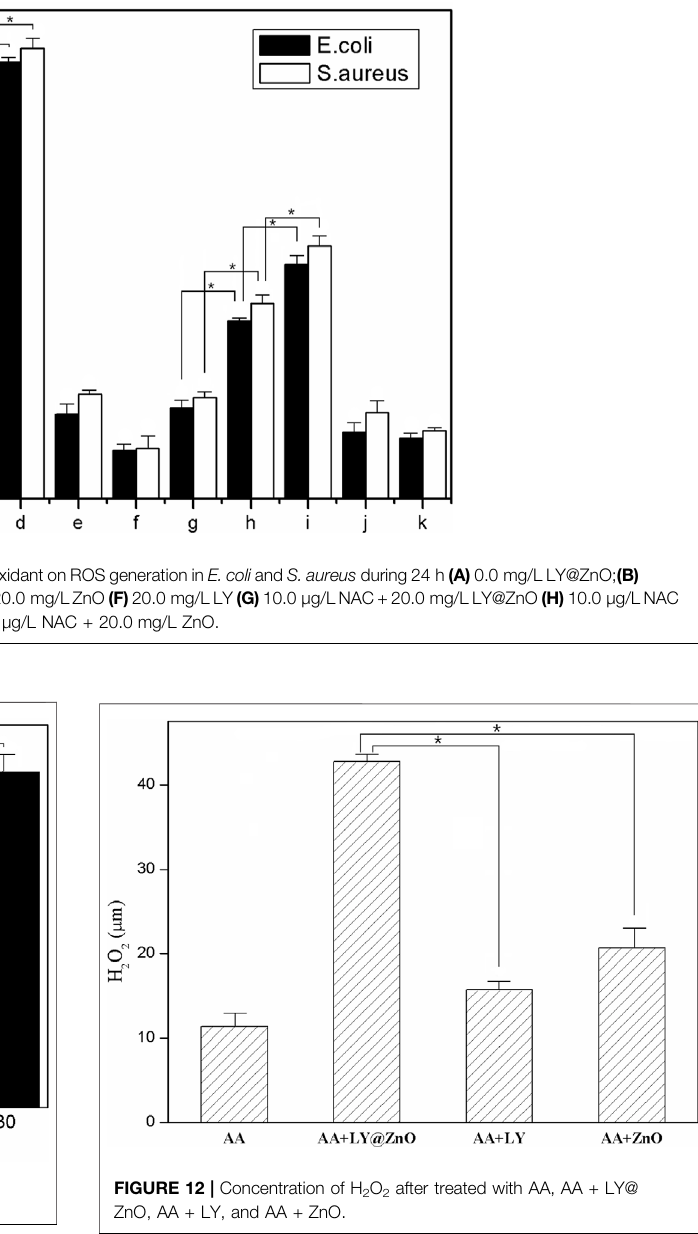
Frontiers in Chemistry |